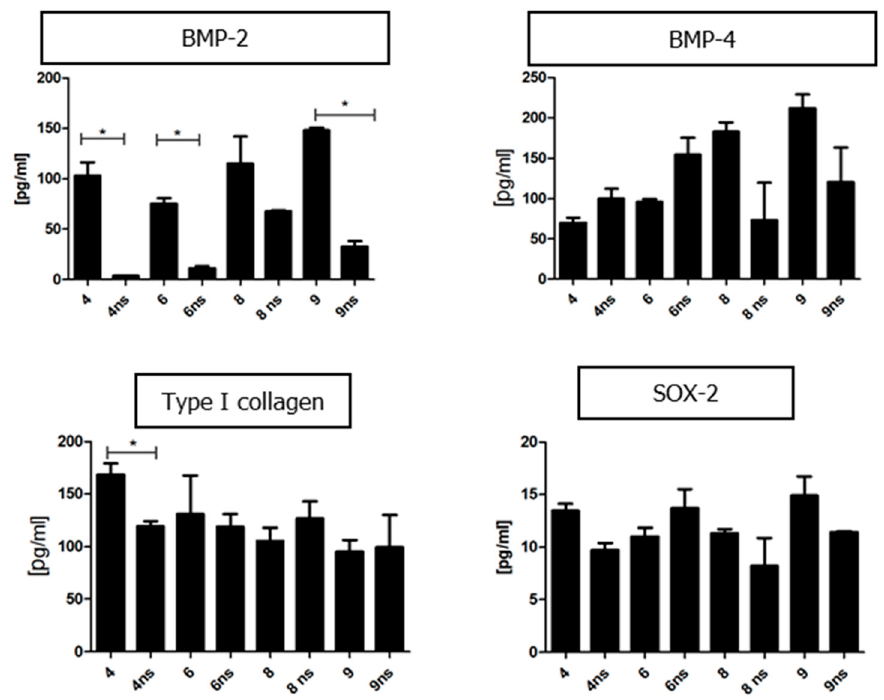
Figure 14. The levels of analysed proteins in the conditioned culture media under osteogenic conditions and standard conditions (non-stimulated control, ns); * p < 0.05 (materials described in Table 3).